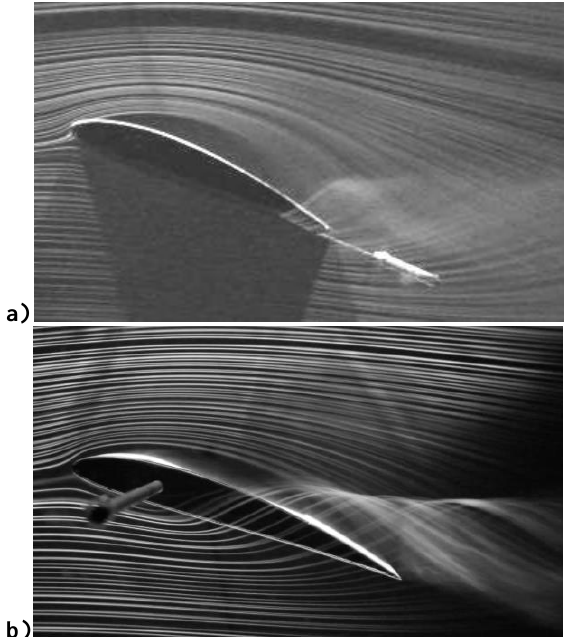
Fig. 5. Smoke wire results for Re=5x10 4 , α=20º and z/s=0.1 a) uncontrolled case, b) partial flexible airfoil .